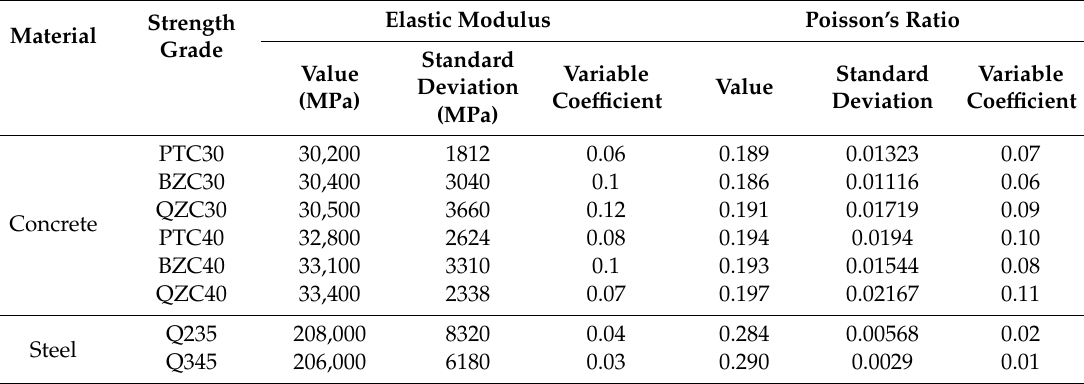
Table 2. Measured values of elastic modulus and Poisson’s